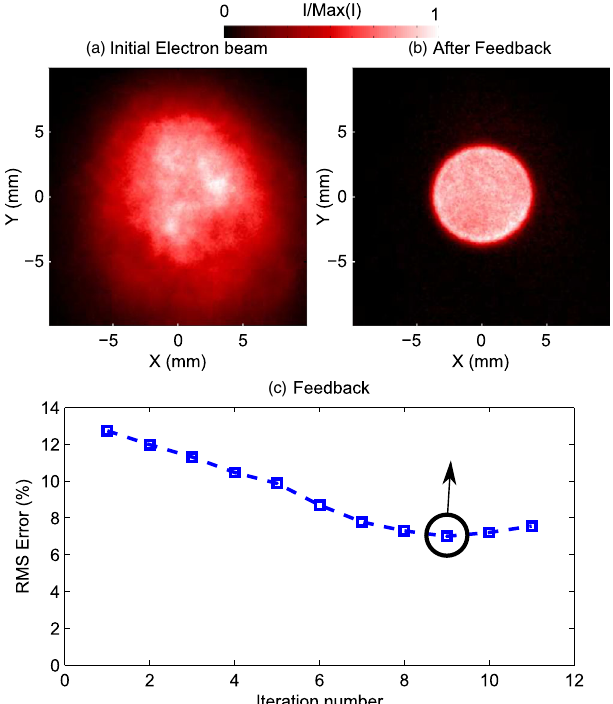
FIG. 7. (a) Initial unshaped electron beam imaged on the fluorescent screen. (b) Final output of electron beam-based feedback, with no profiling of the drive laser. (c) Progress of feedback versus iteration. The distribution shown in (b) is